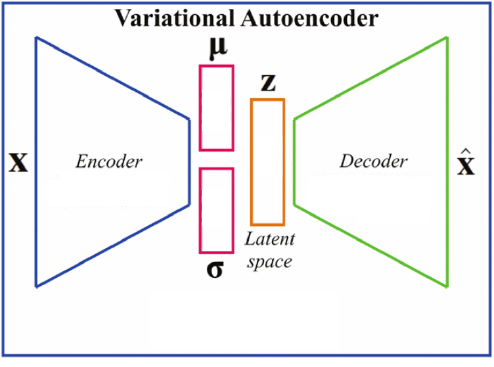
Figure 21. Variational Autoencoder, adapted from